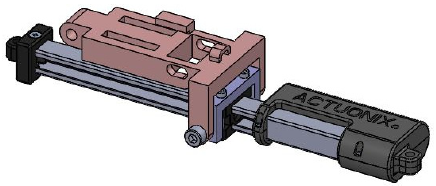
Figure 6. Actuator side element (pink) of the V structure for the elastic lamina support in the case of characterization of sensors used with fixed radius of curvature.